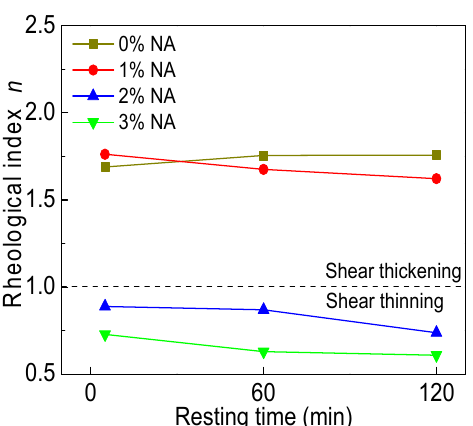
Figure 29. Influence of resting time on n.